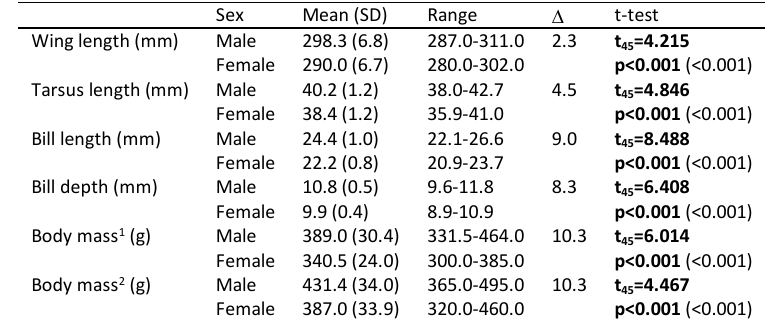
Table 1. Body measurements of male and female snow petrels and percentage of difference between sexes for each measurement. For t-tests homogeneity of variances we checked using a Brown and Forsythe tests (Brown and Forsythe 1974), and corrected p values are reported (uncorrected in brackets). Significant differences with a false detection rate of 0.10 are shown in bold.  is the difference in %. The sample size is 47 individuals.